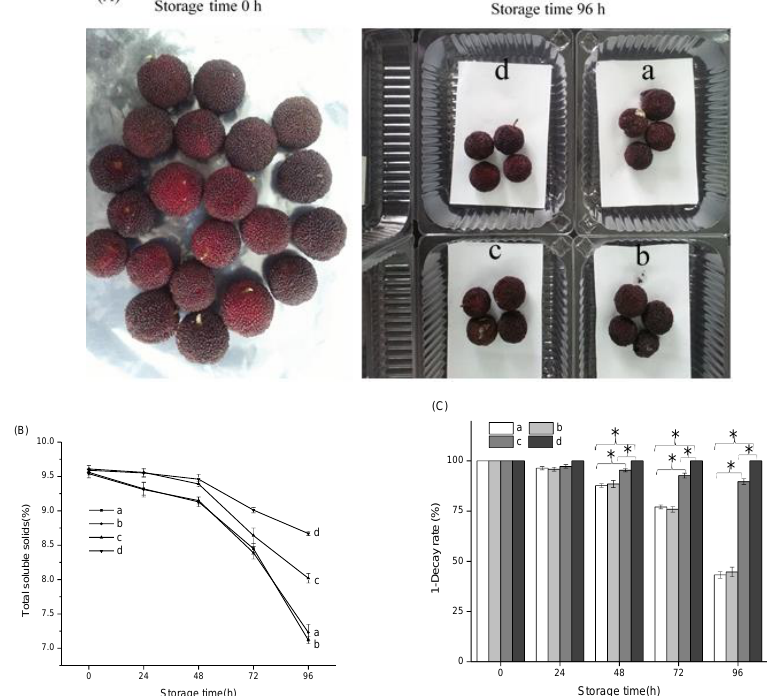
Figure 7. Chinese bayberry fruit at different storage times with different treatments ( A ); Total soluble solids ( B ) and Decay rate ( C ) of Chinese bayberry fruit packaged with different pads; a: The ethyl cellulose pads, as control, b: The ethyl cellulose pads modified by permutite, c: The ethyl cellulose pads modified by Ag + /Zn 2+ -permutite, d: The ethyl cellulose pads modified by A g+ /Zn 2+ -permutite/CEO; * means significantly different at p < 0.05 level.